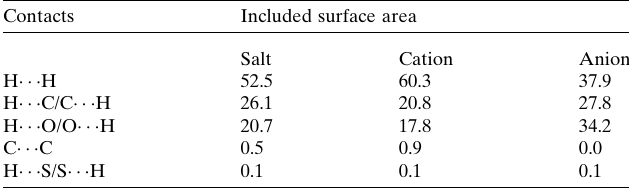
Table 2 Percentage contributions of interatomic contacts to the Hirshfeld surface for (I).